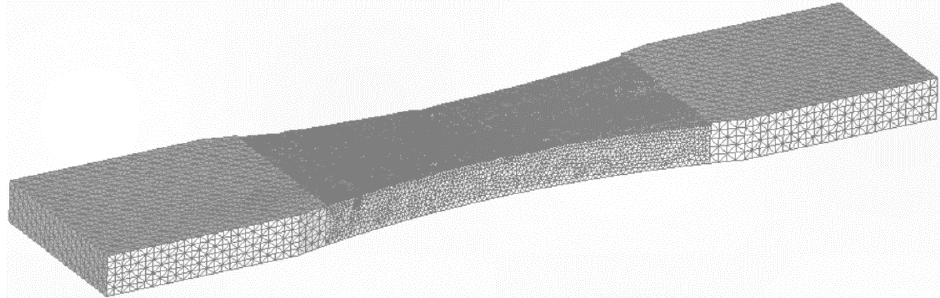
Figure 9. The coarse mesh, 300,233 ten nodded iso-parametric tetrahedral elements and 437,380 nodes.